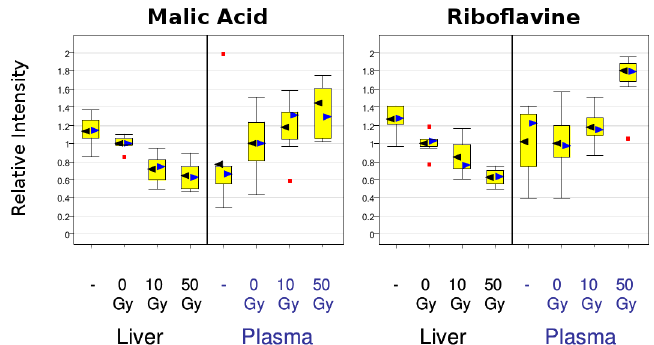
Fig 3. Example of consistent metabolite signatures in liver and plasma. Malic acid and riboflavine are shown as two examples of metabolites, which showed distinctive, consistent signatures in both liver and plasma samples. Supporting information tables show further hits that were consistently altered post-radiation in either liver, or plasma, or